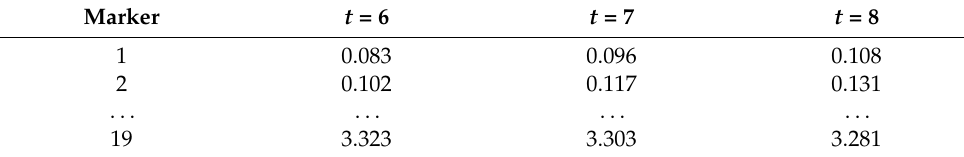
Table 13. Forecasted x coordinates for h =